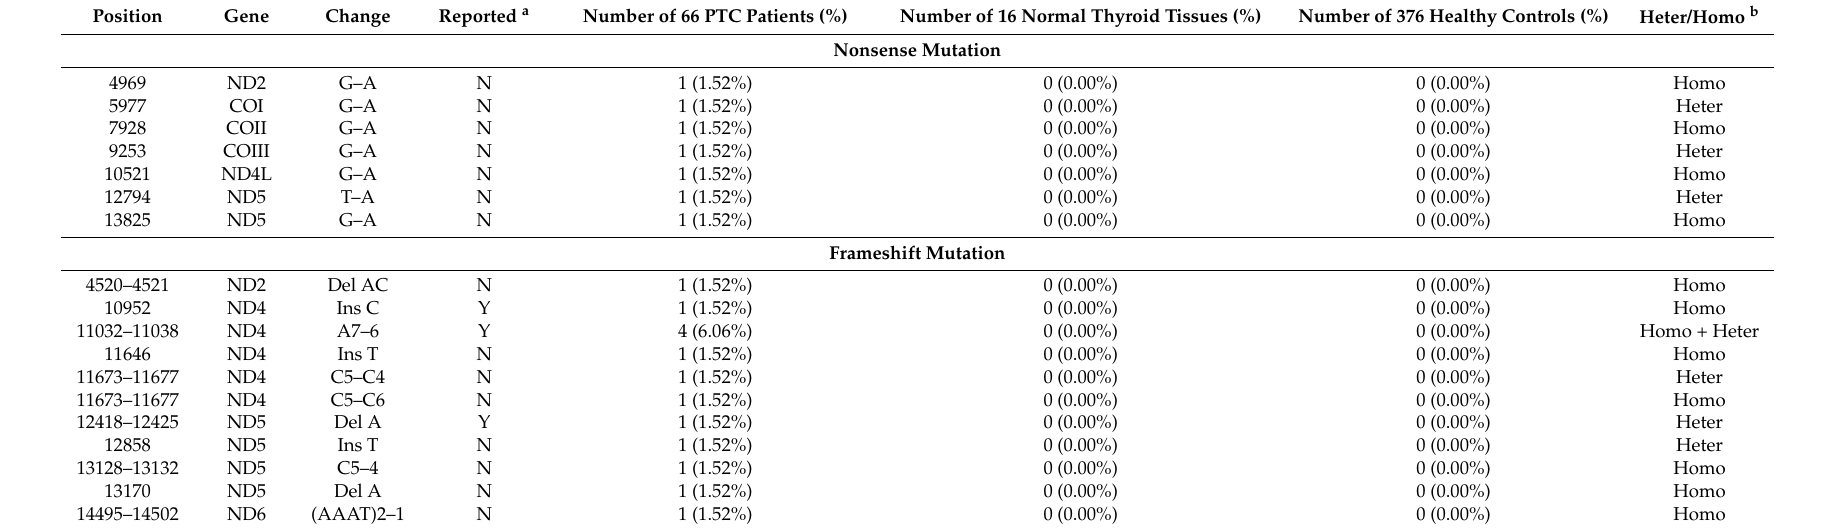
Table 2. Nonsense and frameshift mutations identified in protein-coding